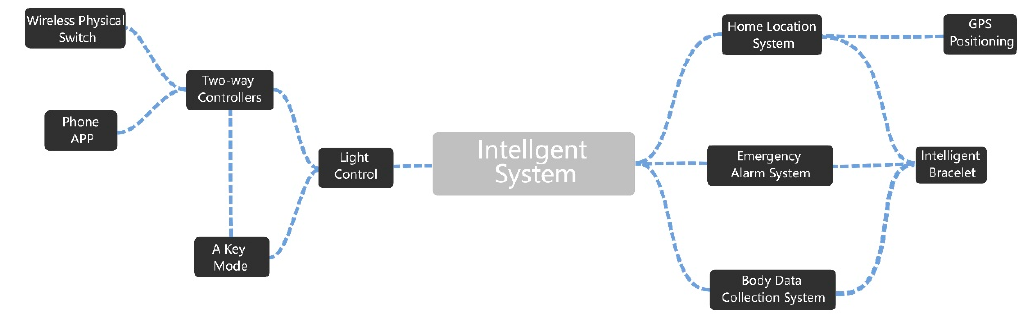
Figure 14. Schematic diagram of the intelligent control system.